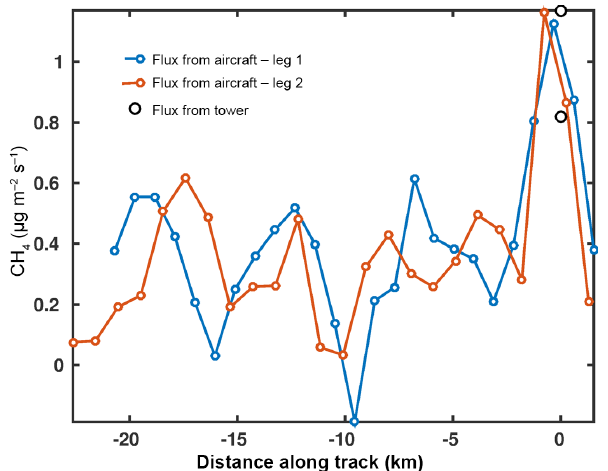
Figure 6. Plot of methane flux derived using RFM versus distance from flux tower for two flight legs on 25 August. Positive (negative) distance is east (west) of the tower position. The east to west tran- sect (blue) was flown 30min after the west to east transect (orange). Black circles are the methane flux measured by the tower at the time nearest to when the aircraft passed the tower.